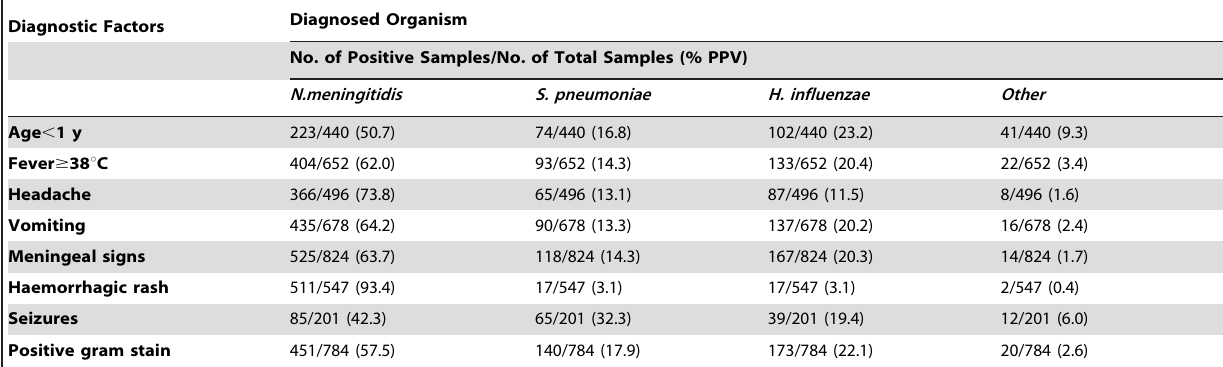
Diagnostic Factors Diagnosed